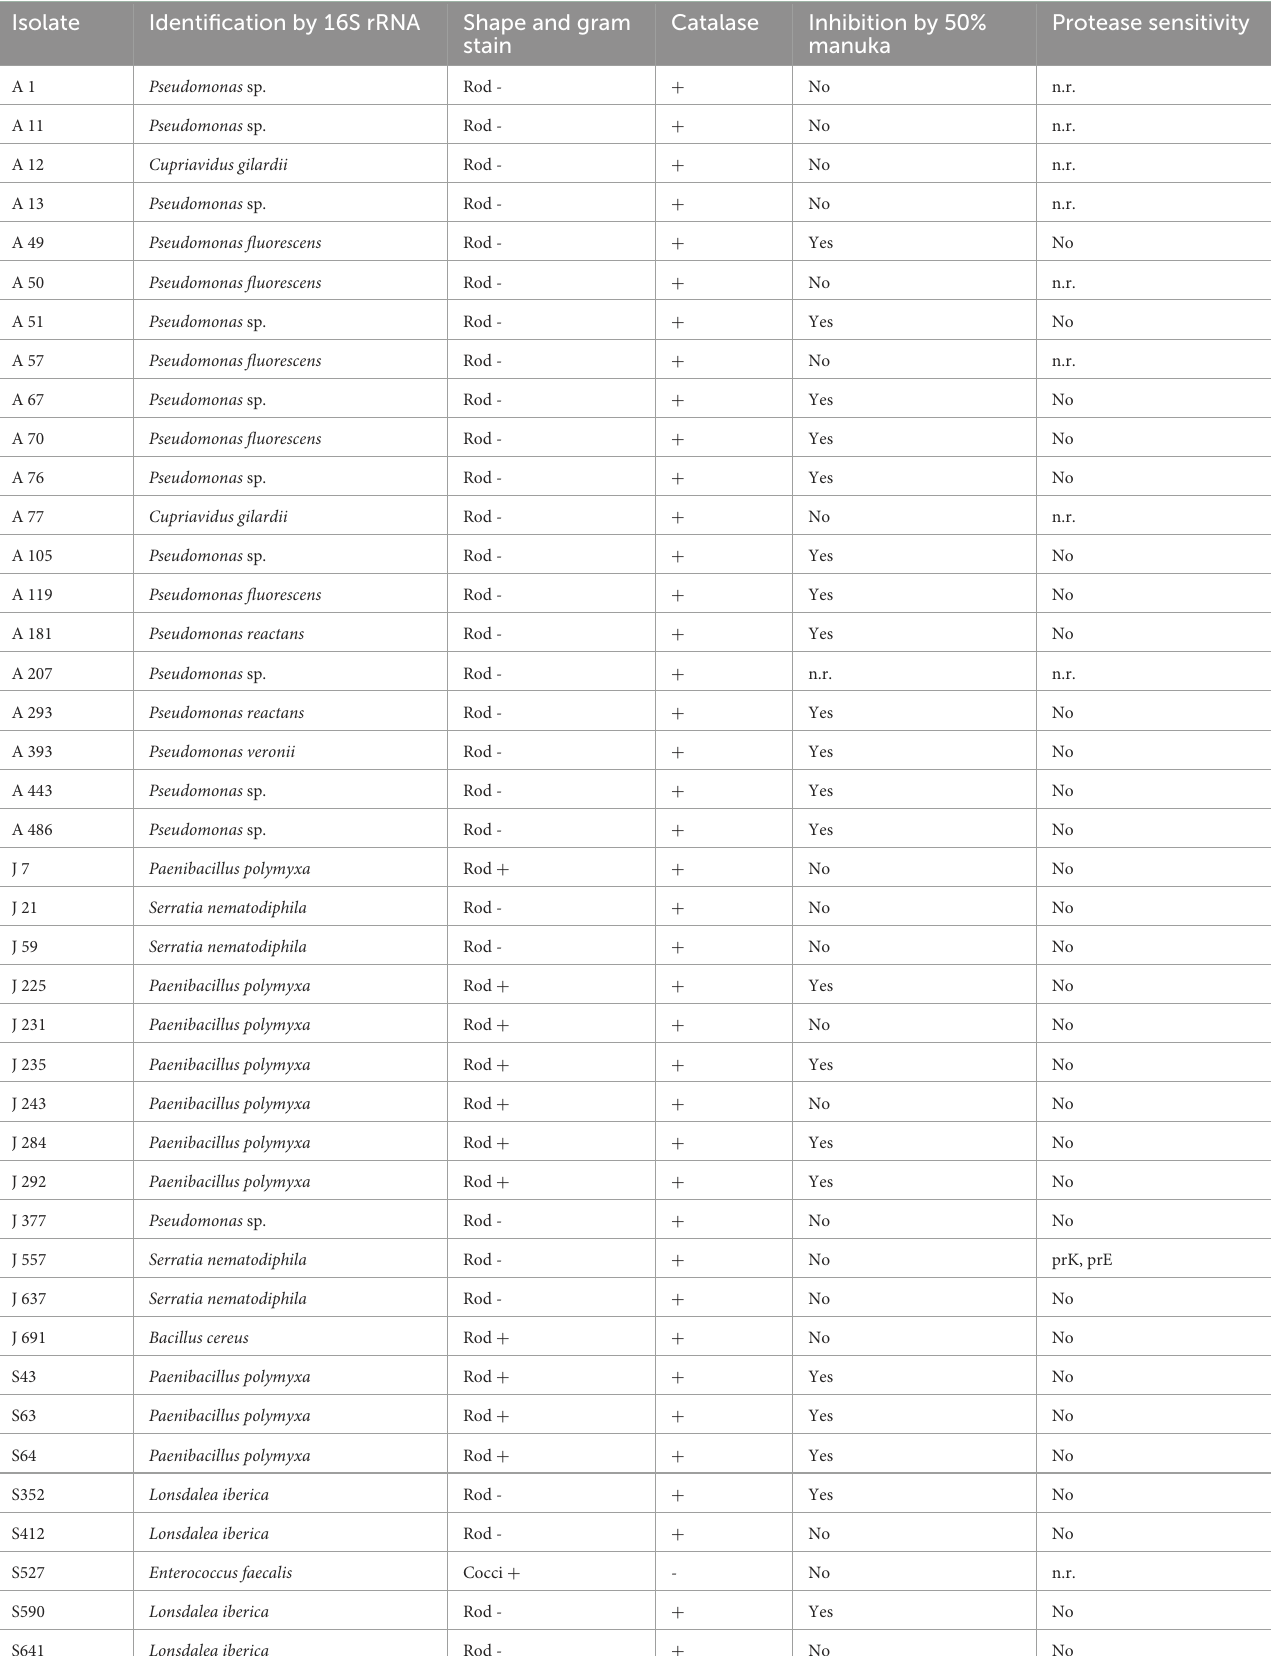
TABLE 2 Characteristics of select honey stomach isolates collected in April (A), June (J), and September (S), and directly from August hive honey (TH). Isolate Identification by 16S rRNA Shape and gram stain A 1 Pseudomonas sp.